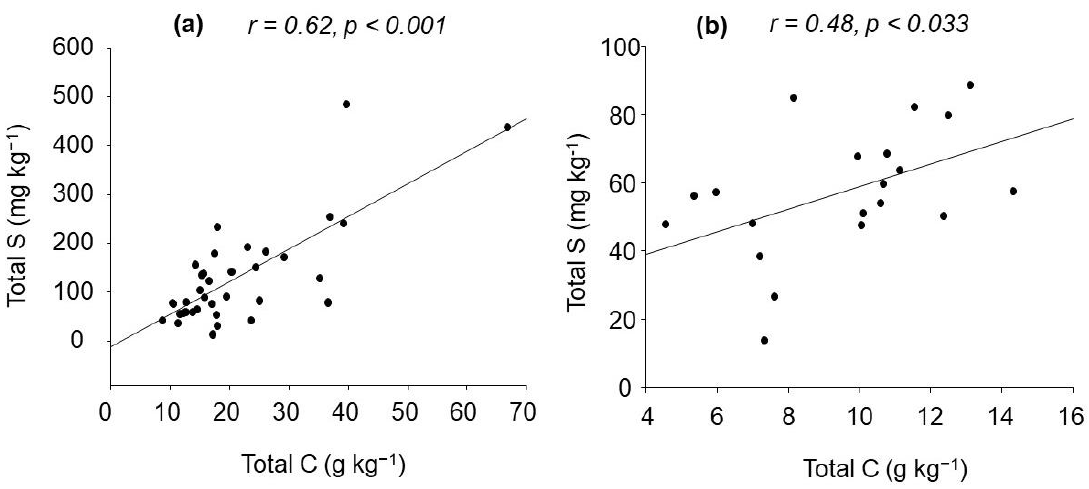
Figure 3. Pearson correlation between ( a ) Dompem total S and SOC and ( b ) Adansam total S and SOC. Table 3. Soil and δpH, total C, N, S and sulphate contents of soils from different farms in Dompem ( n = 9 ± One standard error of means) and Adansam ( n = 5 ± One standard error of means).